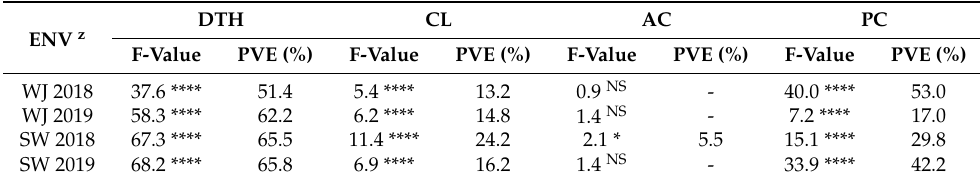
Table 2. Effects of Hd1 allele types on major agronomic traits of 293 Korean rice cultivars.